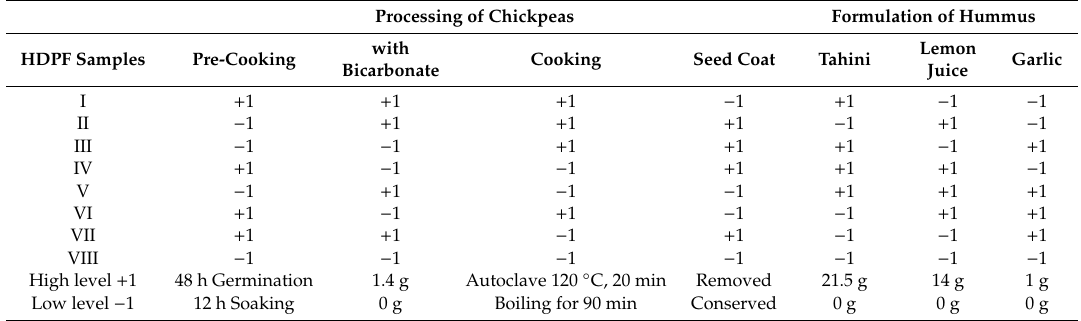
Table 1. The screening Hadamard matrix with seven factors and eight samples of hummus with di ff erent processing and formulation